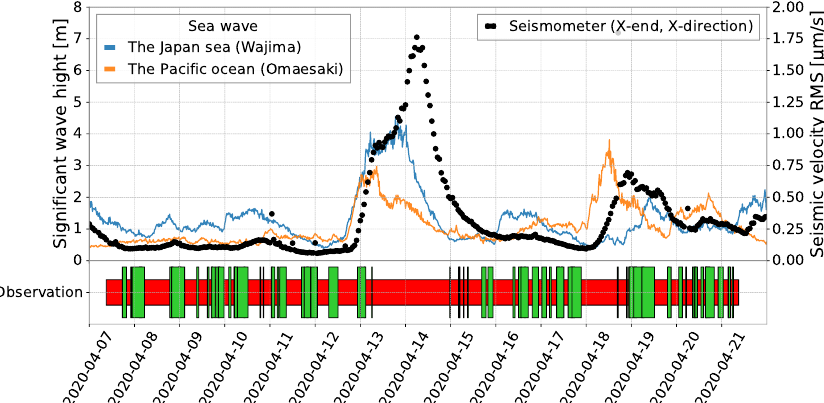
Figure 11. Comparison of the microseisms and the observation state of KAGRA during O3GK [44]. The blue and orange lines show the significant wave height in the Sea of Japan (Wajima) and Pacific Ocean (Omaesaki), respectively, opened in NOWPHAS [43]. The black markers are the RMS values of the seismic velocity in the 0.1–0.3 mHz band for every hour, measured at the X-end of KAGRA. The bottom bar graph shows the observation status of KAGRA during O3GK [37], with the science mode (green) and others (red, mainly the unlocked